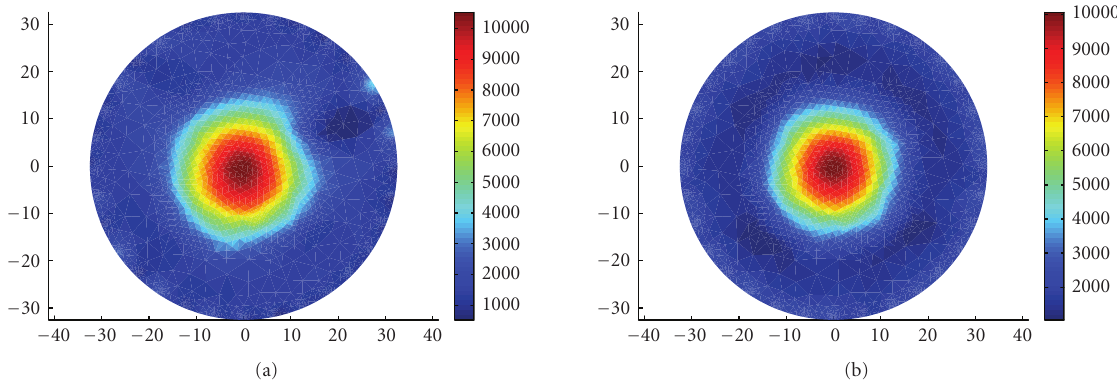
Figure 5: FDM EIT reconstruction of a glass disk (20mm in diameter) is in the center of a circular saline tank. (a) FDM measurements. (b) Emulation results. The scale shows the impedance in Ω